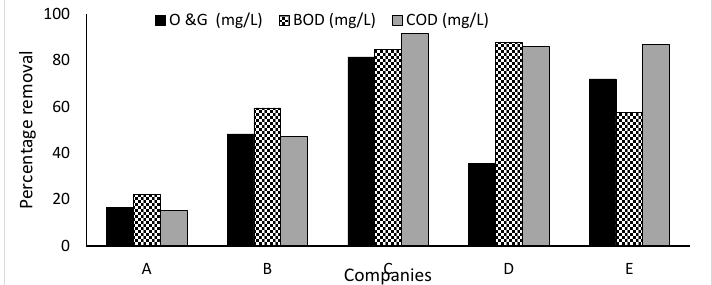
Figure 2. Wastewater Treatment Plant (WWTP) removal efficiencies of Companies A, B, C, D and E